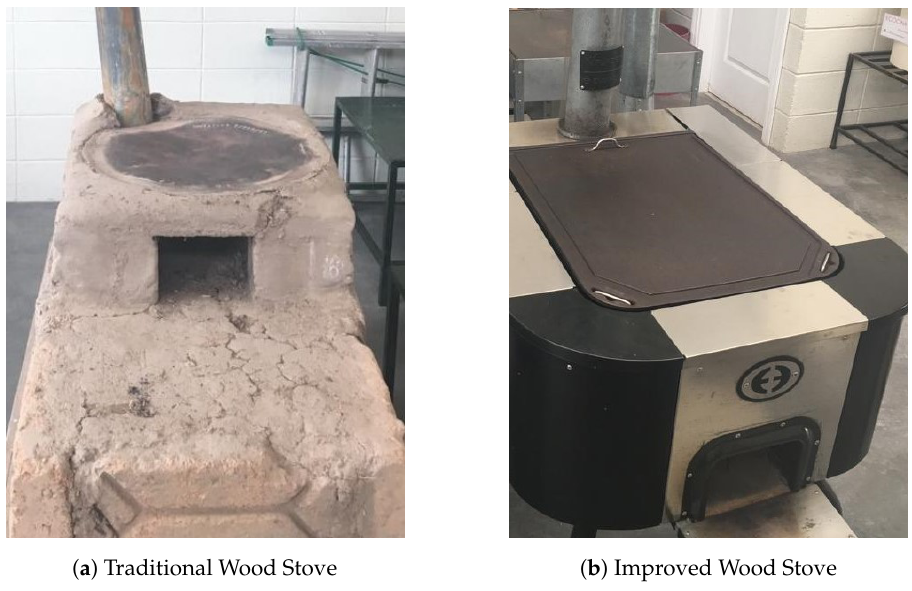
Figure 3. Traditional-style stove commonly used in Honduras, in comparison with the Improved cookstove model (Ecofogon) being distributed by the Honduran government. Pictures taken by